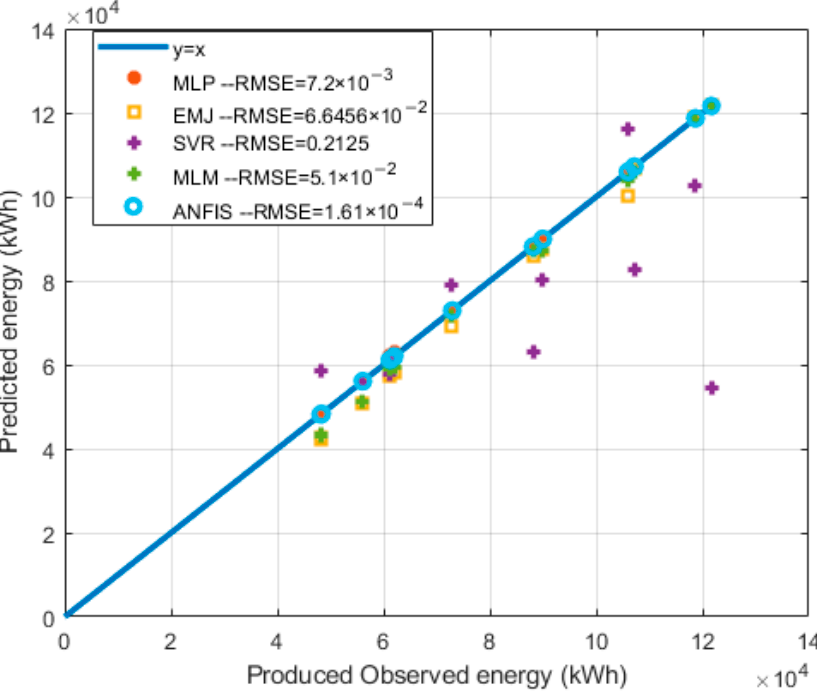
Figure 18. Cotonou: correlation between observed and estimated wind energy output